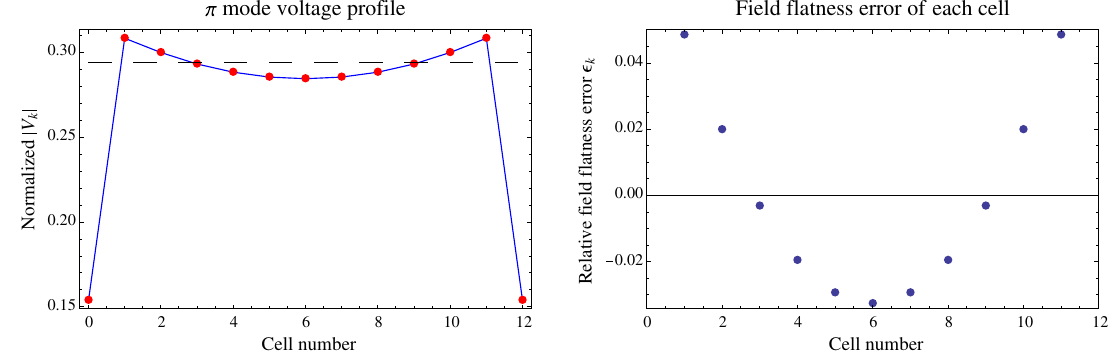
FIG. 5 (color online). This is an example of a field profile and error. The dashed line in the graph on the left is hj V ji which was defined in Sec. IIA1. In this example, the field error is